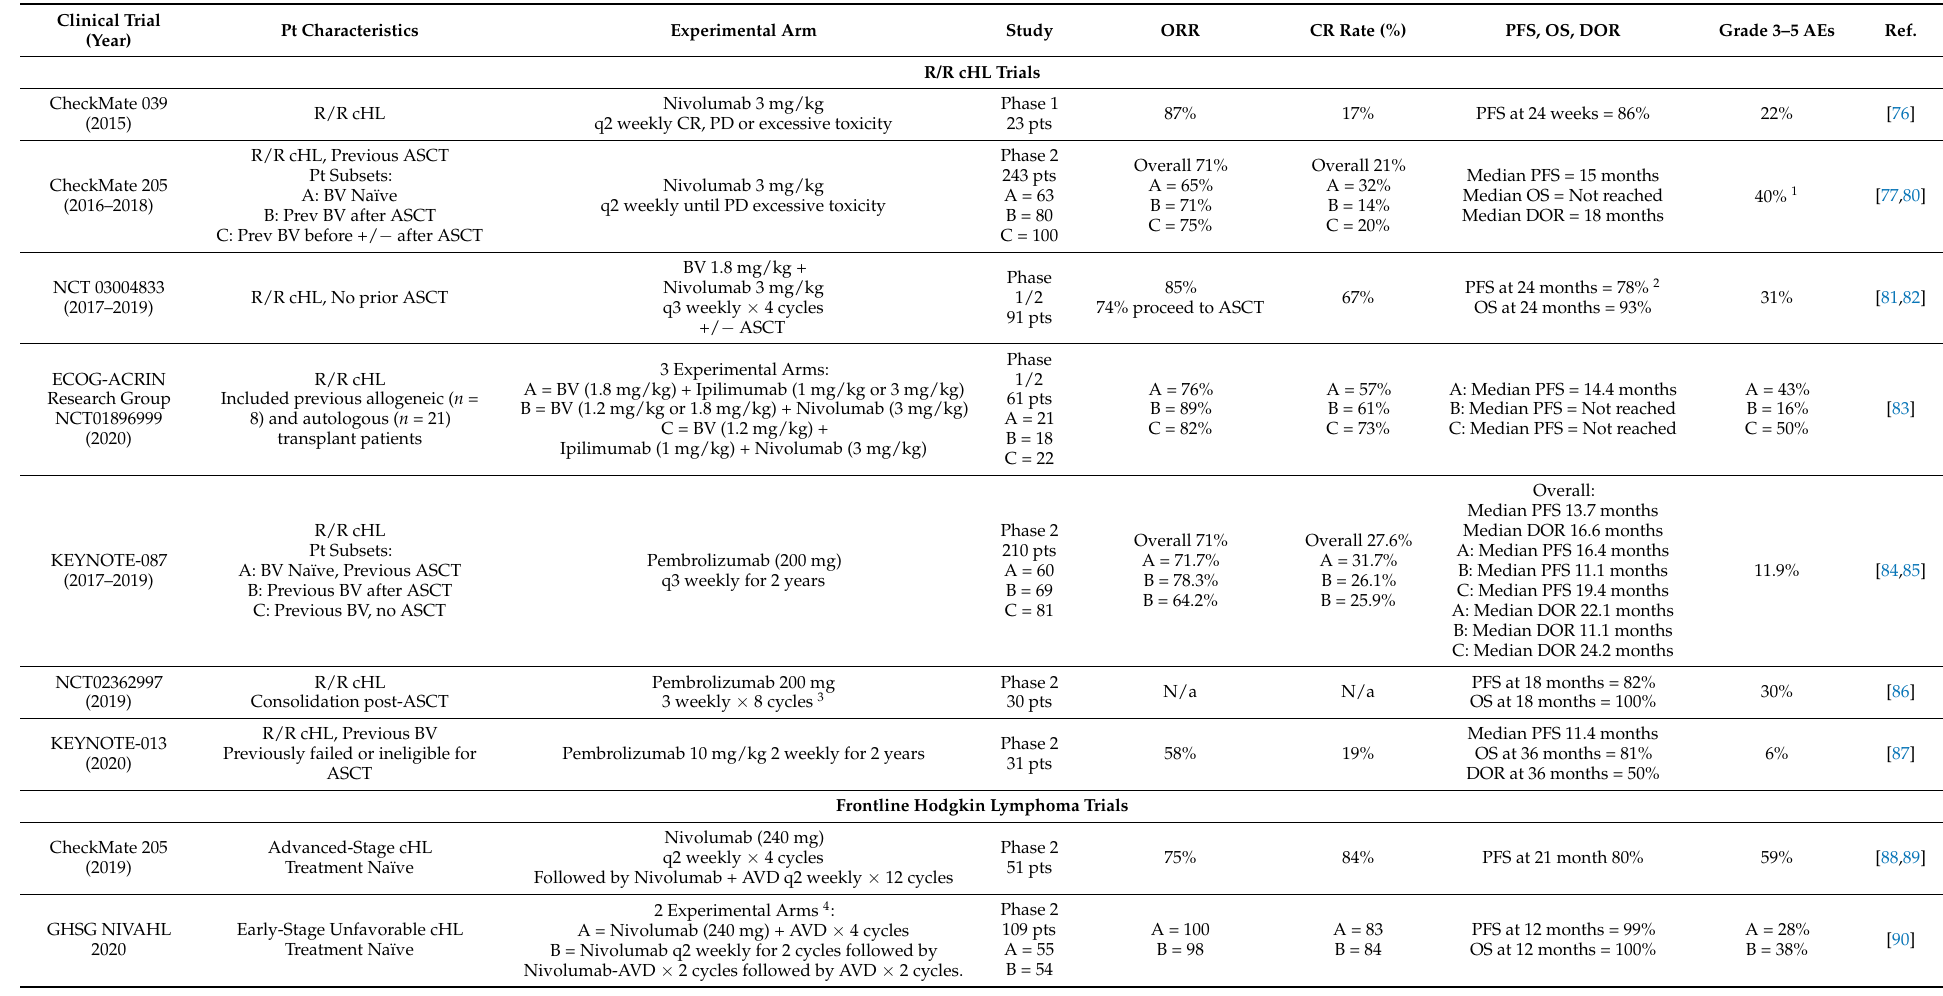
Table 1. Pivotal Trials in the Use of Immune Checkpoint Blockade in Classical Hodgkin